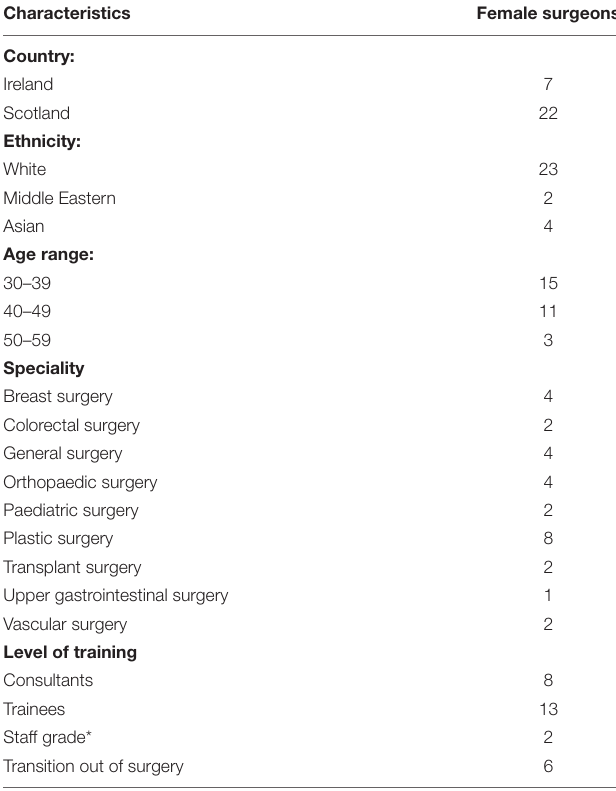
TABLE 1 | Participant